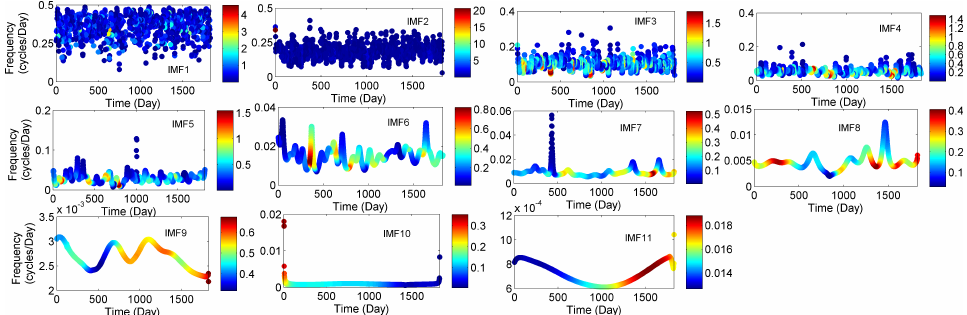
Figure 8. The time-frequency-amplitude spectra of the IMFs of solar radiation.